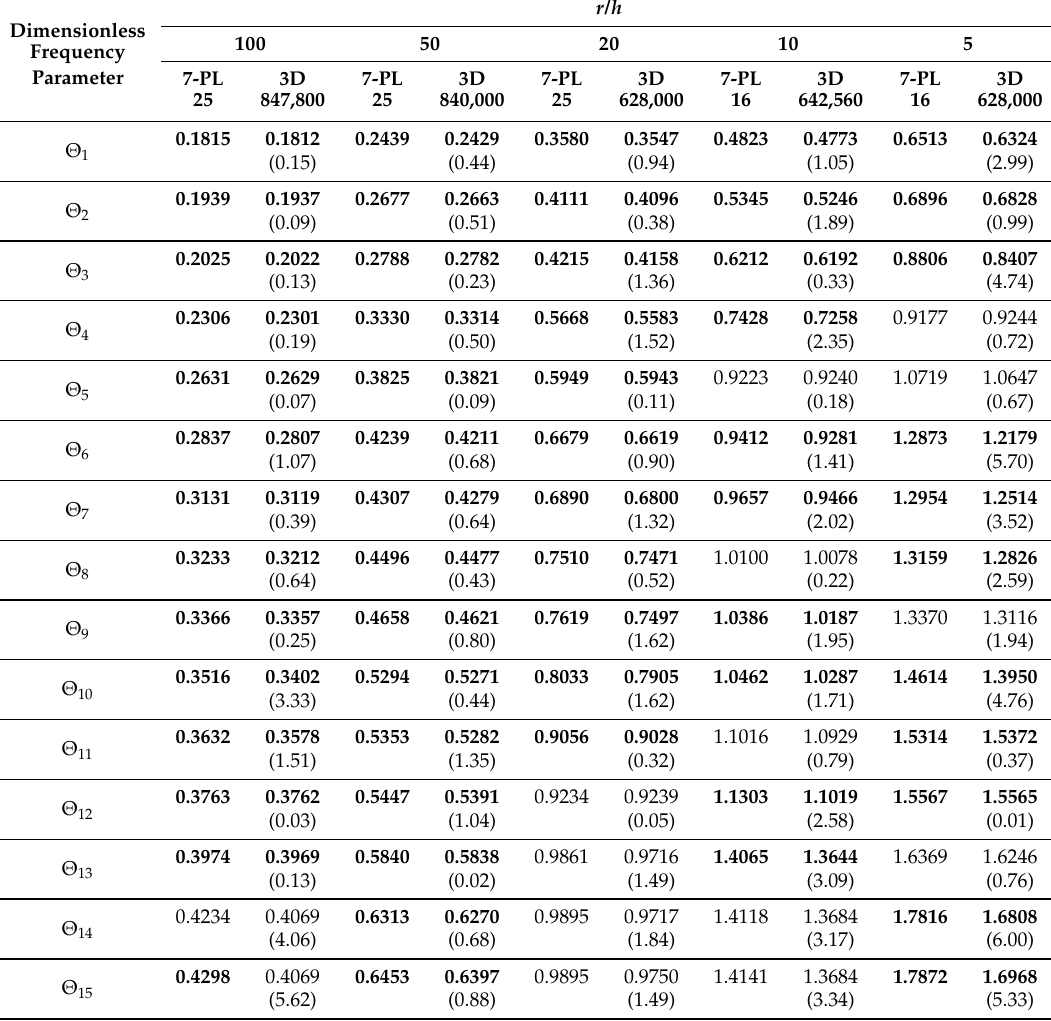
Table 18. Dimensionless natural frequencies parameter Θ for cylinders with linear thickness variation and CC boundary conditions, L / r =